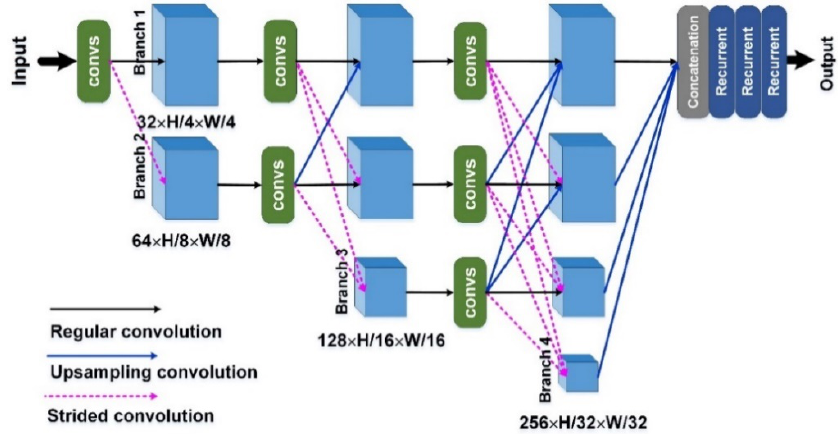
Figure 4. Architecture of HRNet with “convs” blocks and four branches.